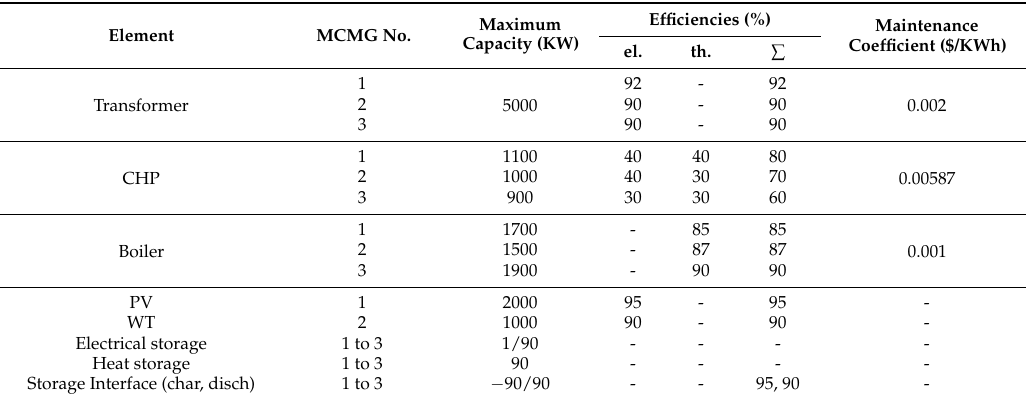
Table 1. Technical specification of MCNMG’s elements.